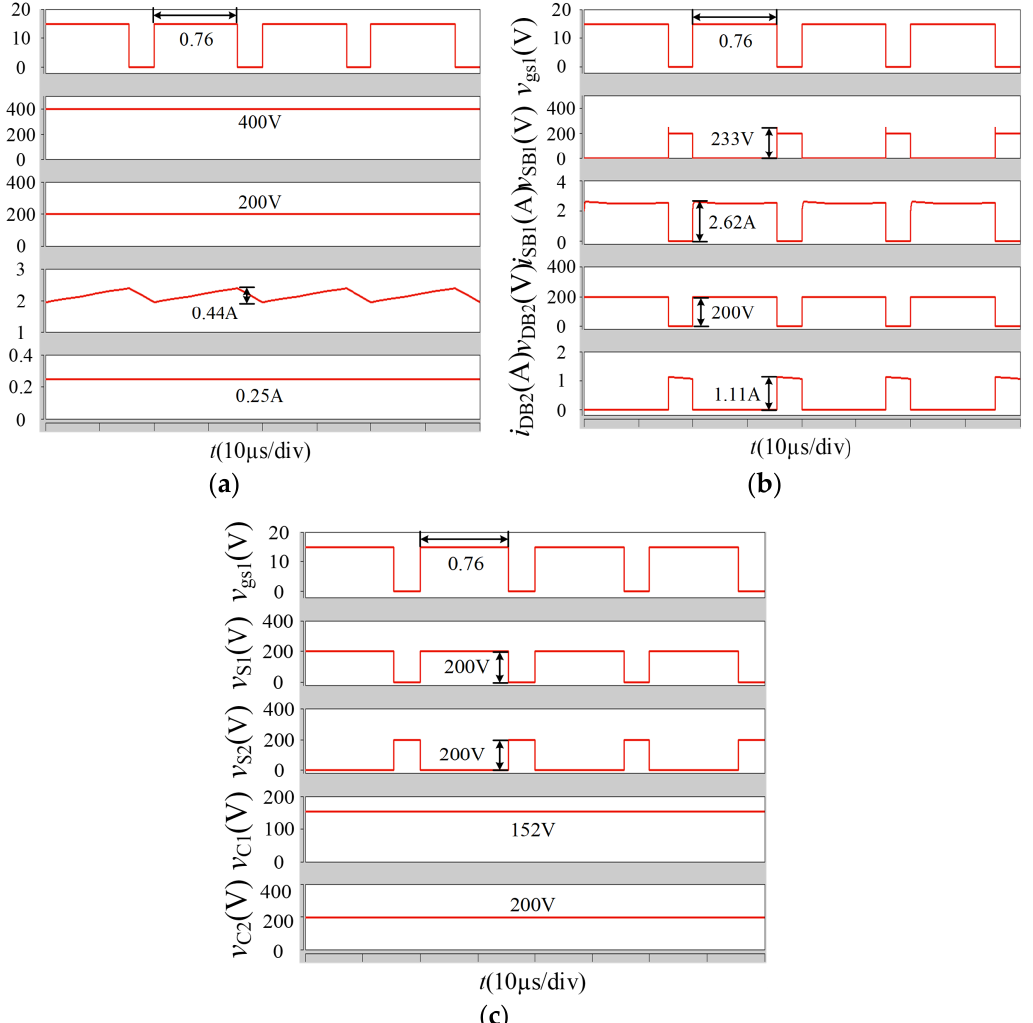
Figure 8. The steady waveforms in step-up mode ( V 2 = 48 V): ( a ) v gs1 , v 1 , v CB , i L1 , i L2 ; ( b ) v gs1 , v SB1 , i SB1 , v DB2 , i DB2 ; ( c ) v gs1 , v S1 , v S2 , v C1 v C2 .